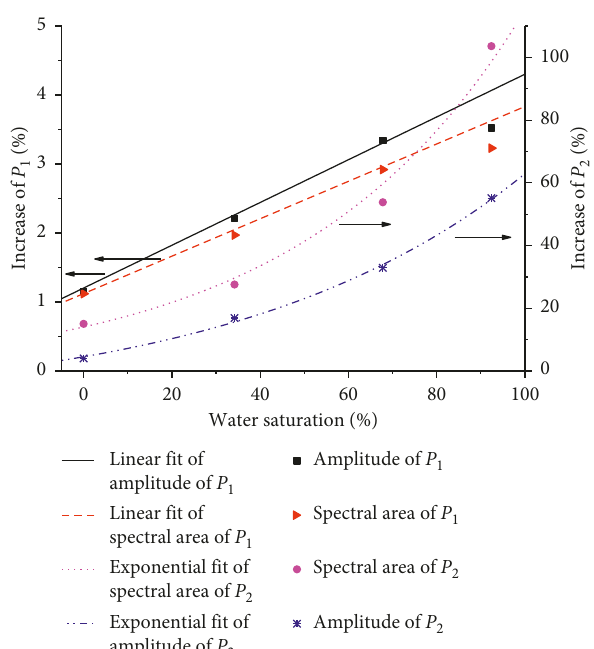
Figure 4: Increases in amplitude and spectral area with water saturation.